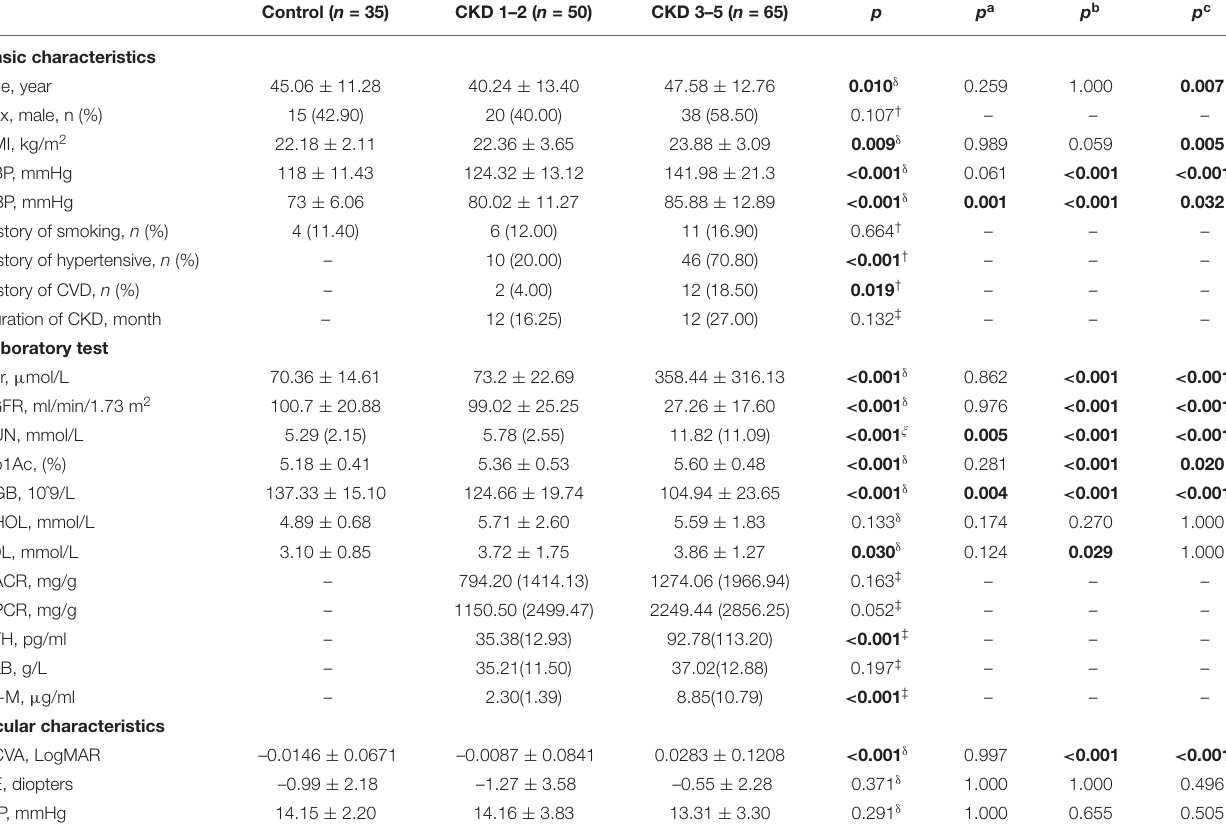
TABLE 1 | Comparison of basic characteristics among the three